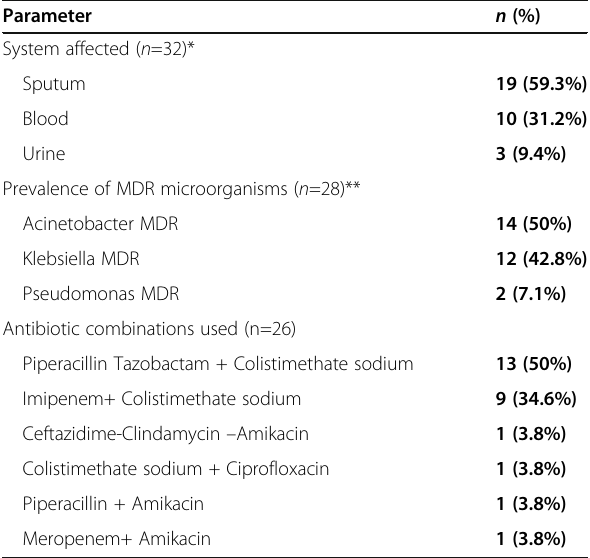
Table 2 Descriptive statistics of affected systems, MDR microorganisms and antibiotic combinations used according to the University's Antimicrobial stewardship program Parameter n (%) System affected ( n